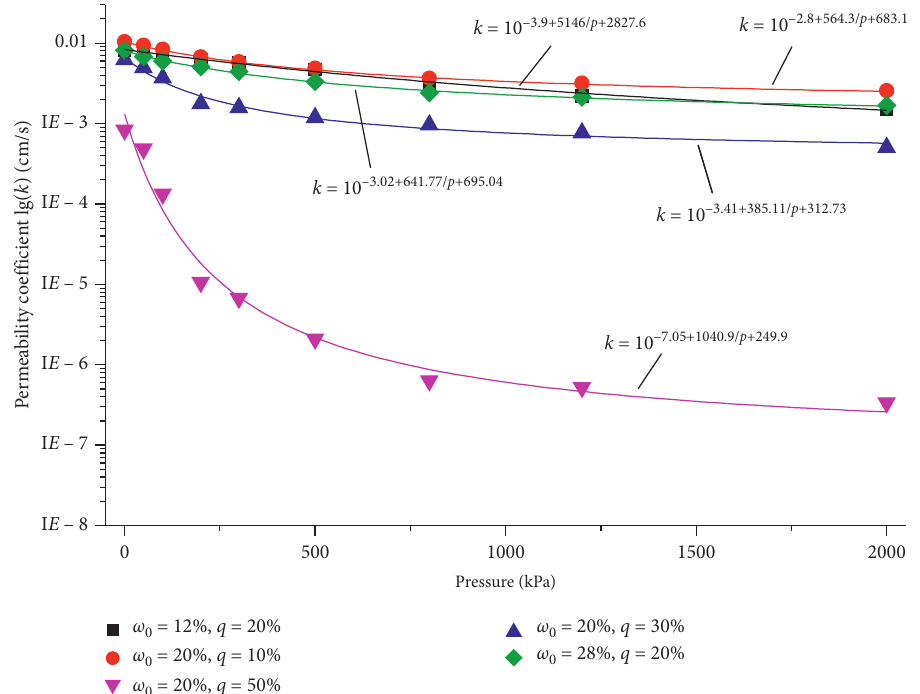
Figure 19: Fitting curves of permeability coefficient and